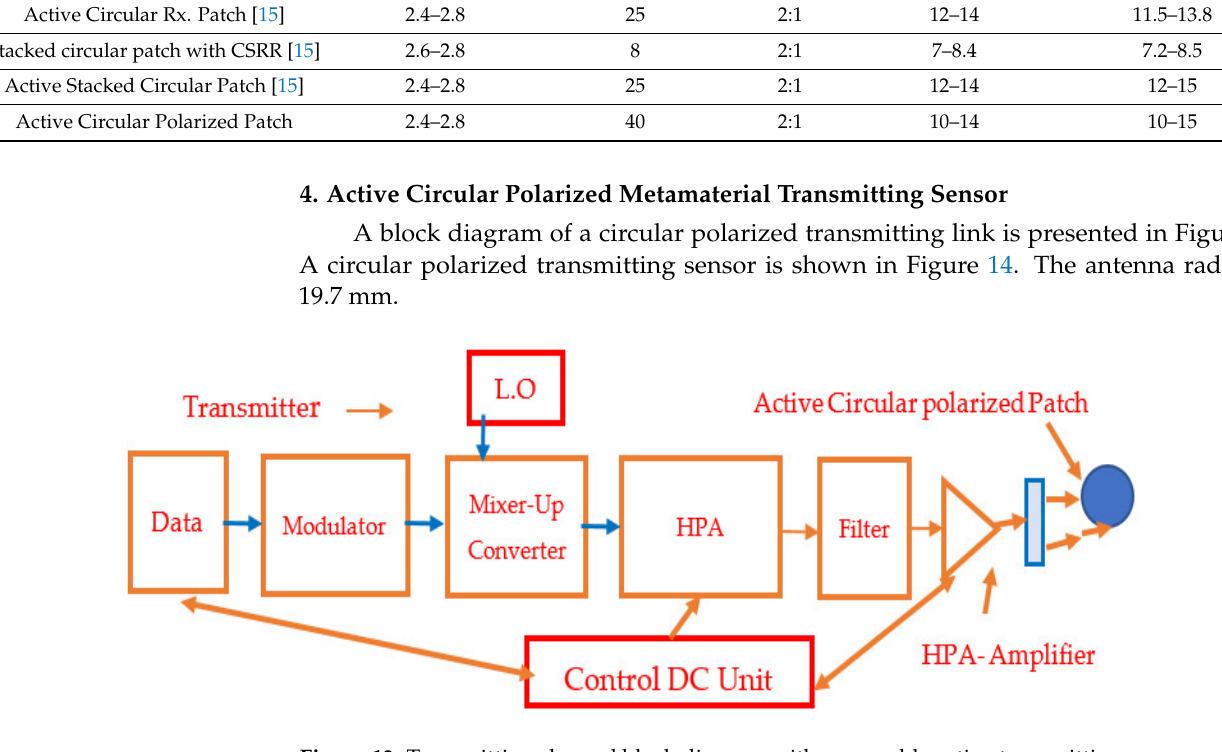
Figure 13. Transmitting channel block diagram with a wearable active transmitting sensor.